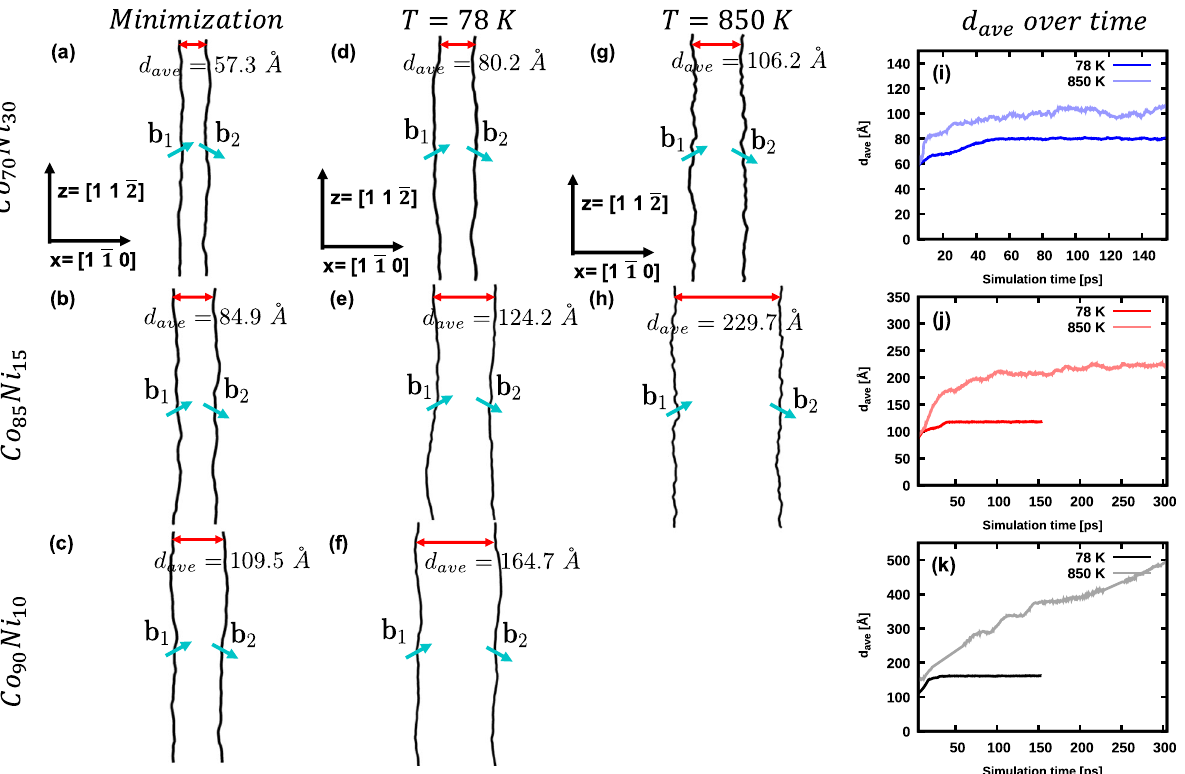
-- Fig. 3 Dissociation of a 1 = 2 ½ 1 10 (cid:2) edge dislocation in NiCo random alloys. The equilibrium positions of the dissociated dislocation after energy minimization are shown in ( a ) Co 70 Ni 30 (positive average SFE), ( b ) Co 85 Ni 15 (zero average SFE), and ( c ) Co 90 Ni 10 (negative average SFE); ( d – f ) show the dissociated edge dislocation at T = 78 K; ( g , h ) show the corresponding dislocations at T = 850 K. The dislocation analysis from OVITO is used, where the black lines represent the two partial dislocations ( b 1 , b 2 are a < 112 > -type dislocations). Regardless of the sign of the average stacking fault energy values, 6 the dissociation width of the edge dislocation remains fi nite at low temperature. i – k tracks the evolution of the average separation distance as a function of time, showing a continuous dissociation in Co 90 Ni 10 alloy at T = 850 K.